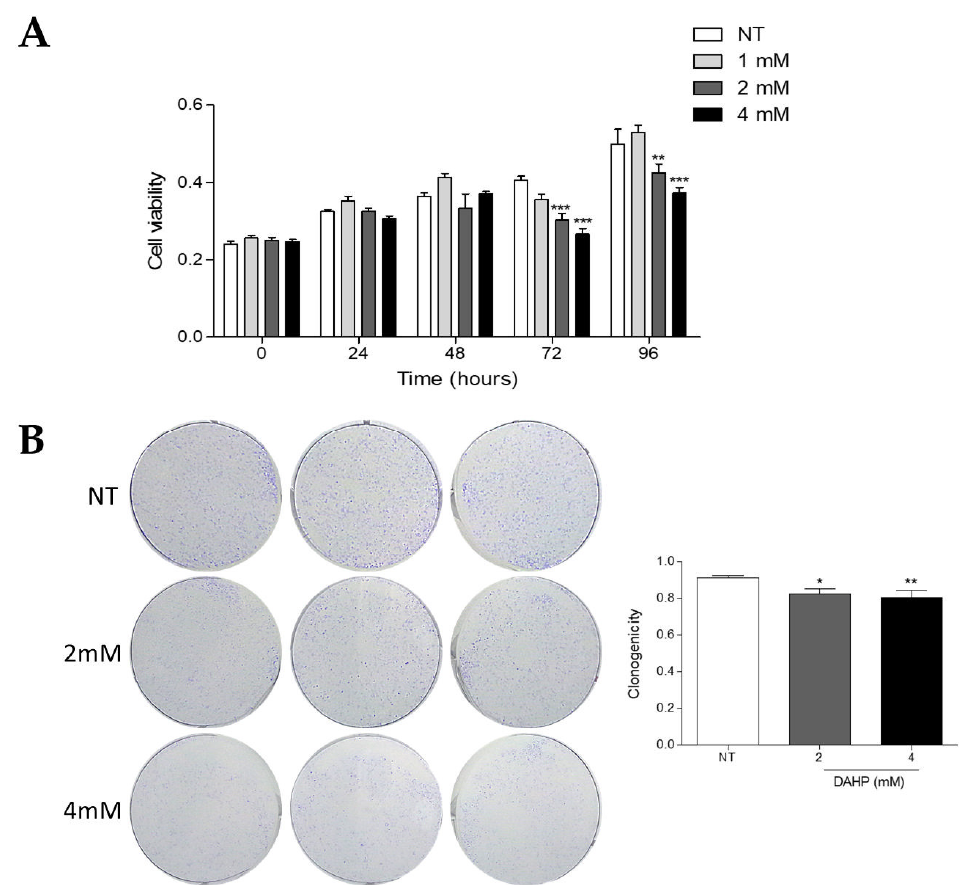
Figure 8. DAHP reduced the metastatic melanoma cell growth. WM983B melanoma cells were treated (DAHP) or not (NT) for 24, 48, 72 and 96 h with 1, 2 and 4 mM DAHP, and viable cells were evaluated by MTT ( A ) and for 9 days with 2 and 4 mM DAHP, and the formation of clones was visualized by a clonogenicity assay ( B ). Values are reported in the bar graphs and expressed as the means ± S.D. The experiments were performed in triplicate. p -values were based on a one-way ANOVA test, followed by Bonferroni’s post-test and two-way ANOVA test, followed by Bonferroni’s multiple comparisons test. *, p < 0.05; **, p < 0.01 and ***, p <